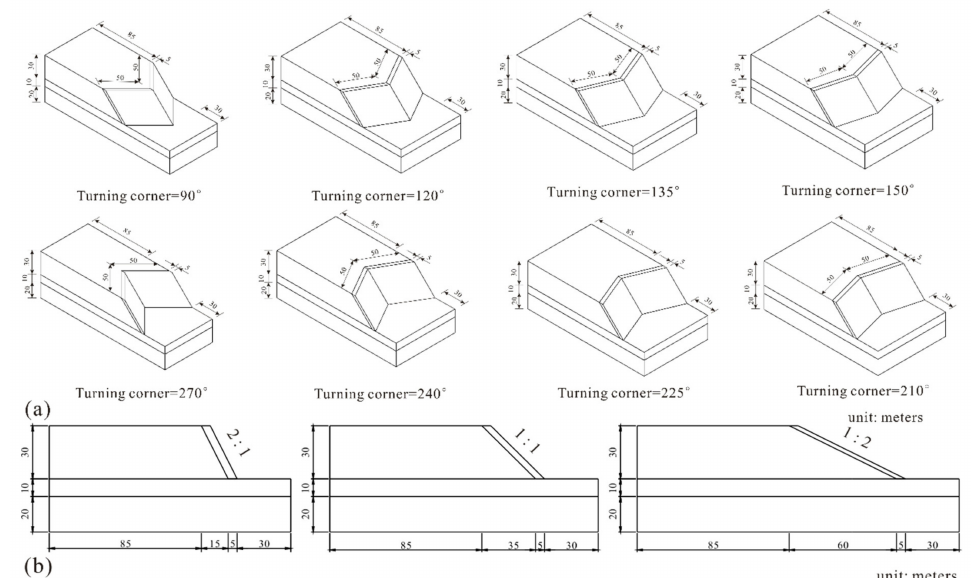
Figure 4. Calculating models with di ff erent corner angles and slope gradients: ( a ) di ff erent corner angles and ( b ) di ff erent slope